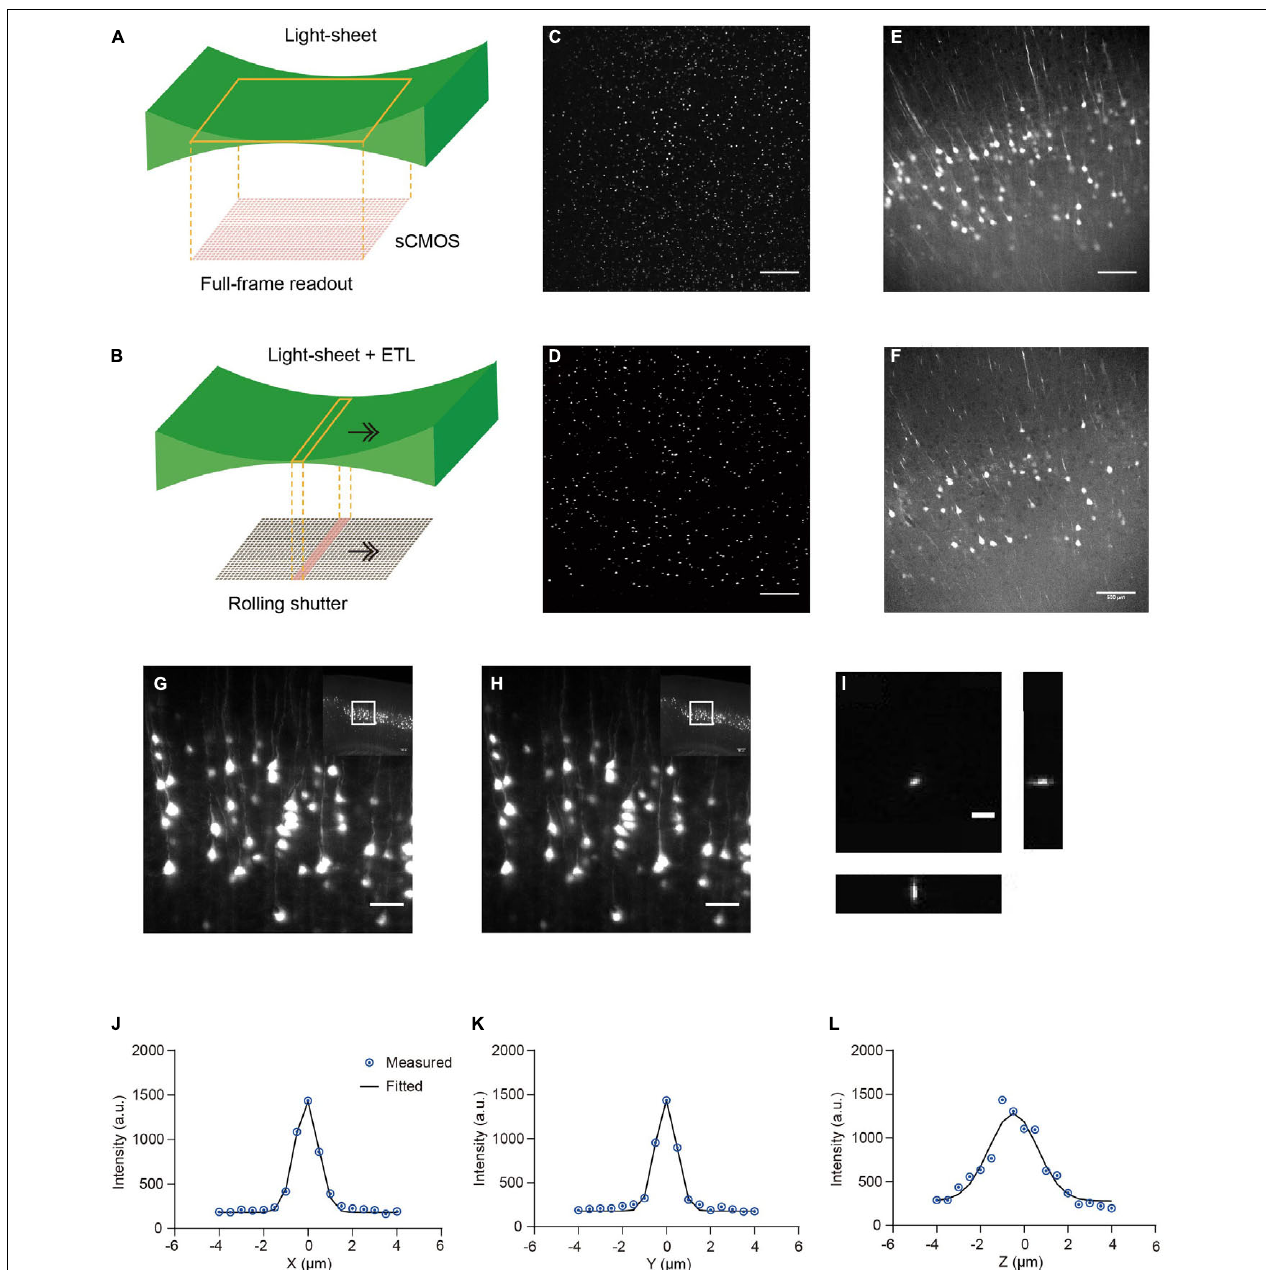
FIGURE 3 | Comparison of stationary light-sheet illumination and tiled light-sheet illumination, non-stop axial scanning during continuous z -axis movement, and optical resolution. (A) Schematic of the stationary light-sheet and scientific complementary metal–oxide–semiconductor (sCMOS) camera chip. (B) Schematic of the axially scanned light-sheet (tiled light-sheet) that moves with slit detection. As the rolling shutter of the sCMOS camera moves synchronously with the light-sheet waist, the final image contains only signal from the waist region, resulting in higher axial resolution across a large field of view (FOV). Arrow, moving direction of light-sheet or rolling shutter. (C) Fluorescent beads (1 µ m) embedded in 2% agarose gel imaged by the stationary light-sheet. At the top and bottom of the image, beads blur and are dimmer because of being out of focus and increase in sheet thickness. Scale bar in (C–F) , 500 µ m. (D) Fluorescent beads imaged by tiled light-sheet illumination showing small bright dots across the whole FOV. (E) An example coronal section of CUBIC-X cleared Thy1-EYFP brain imaged by the stationary light-sheet. (F) Same region imaged by tiled light-sheet illumination showing sharper images across the whole FOV. (G,H) Fluorescence images of the same region obtained with (G) stationary (no moving along Z) imaging and (H) non-stop axial scanning. The images are almost identical. Scale bar, 20 µ m. (I) Fluorescent beads (0.2 µ m) embedded in 2% agarose gel were imaged by the multi-scale LSFM. Regions containing single beads were then cropped out and projected along the XY, YZ, and XZ planes. Scale bar, 5 µ m. (J–L) PSF generated from projected images using the MetroloJ plugin in Fiji. The system has an in-plane resolution of 0.95 µ m that is larger than the optical resolution of the system ( ∼ 0.6 µ m), suggesting that the resolution is limited by the pixel size 0.52 µ m. The axial resolution of 2.1 µ m is also limited by the axial step size of the motorized stage 1 µ